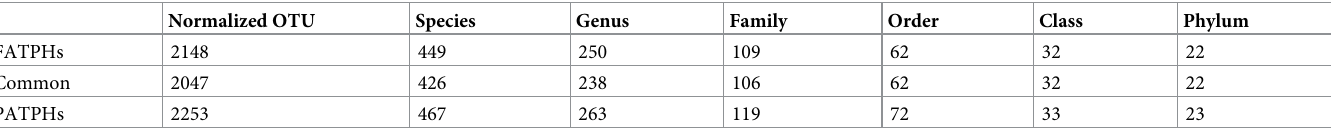
Table 2. Comparison of the group sequencing results between the FATPHs and PATPHs. Normalized OTU